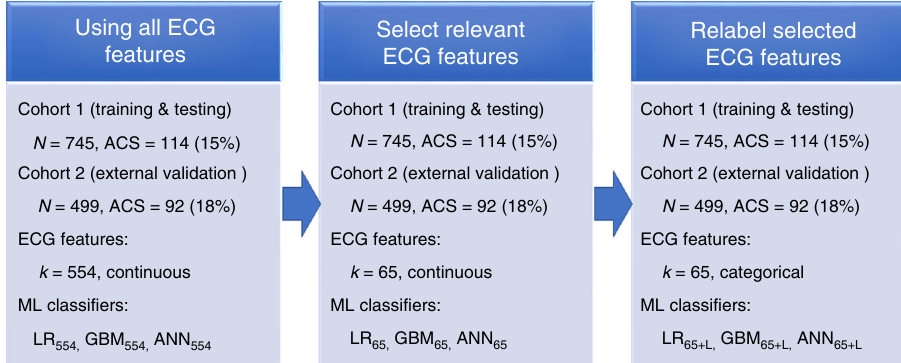
Fig. 1 Stages of dataset derivation and preparation prior to developing the ML classi fi ers. We used all available ECG features ( k = 554), selected ECG features ( k = 65), and selected and relabeled ECG features ( k = 65 + L) to train and test our machine learning (ML) classi fi ers: logistic regression (LR), gradient boosting machine (GBM), and arti fi cial neural networks (ANN). Cohort 1 was used for training and Cohort 2 was used for independent testing. The primary study outcome was acute coronary syndrome